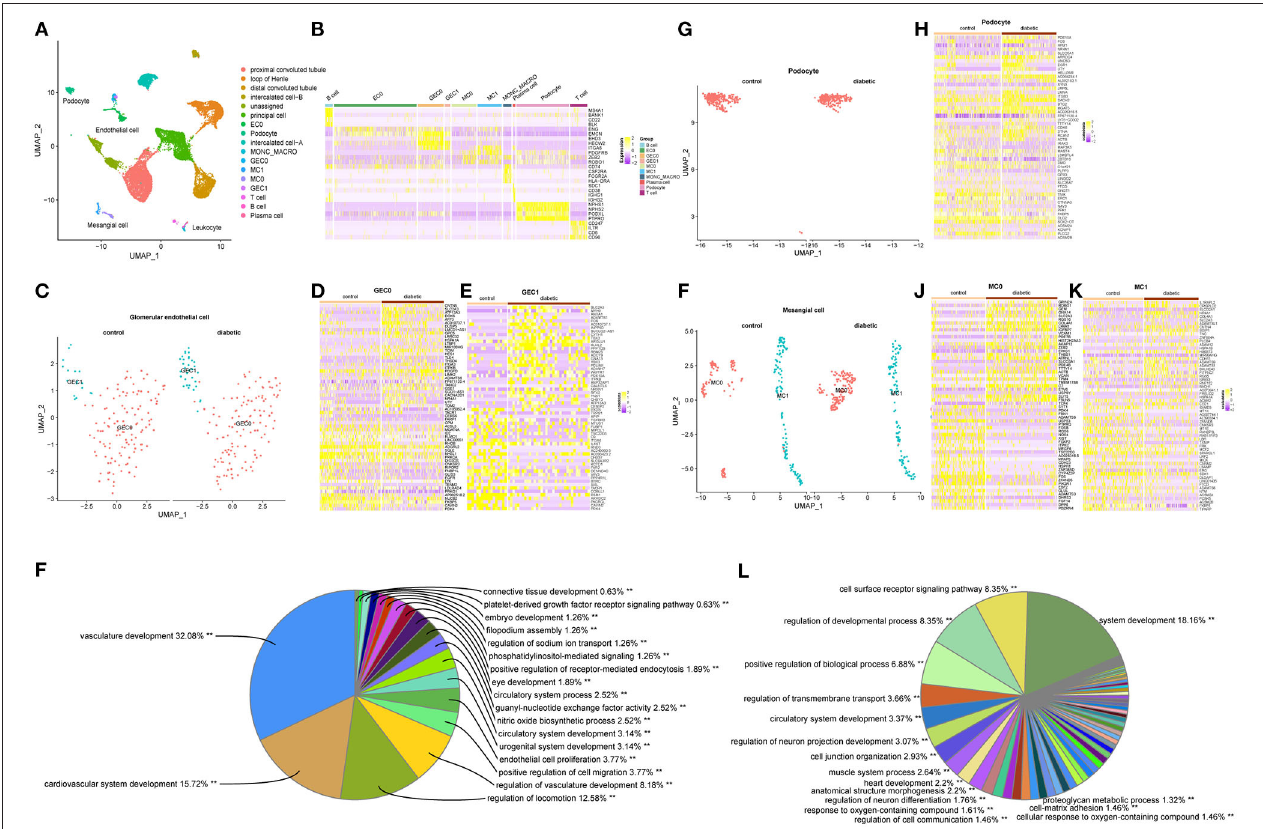
FIGURE 1 | (A) UMAP plot from unsupervised clustering of 23,980 cells from kidney cortex of healthy subjects and patients with diabetic nephropathy. (B) Expression levels of representative genes from each cluster. (C) UMAP plot of the two subclusters of glomerular endothelial cells. (D) Heatmap of top 30 up- and down-regulated DEGs in GEC0. (E) Heatmap of top 30 up- and down-regulated DEGs of GEC1. (F) Pie chart of significantly enriched GO terms group of GEC1. (G) UMAP plot of podocytes in healthy and diabetic conditions. (H) Heatmap of DEGs of podocytes. (I) UMAP plot of the two subclusters of mesangial cells. (J) Heatmap of top 30 up- and down-regulated DEGs in MC0. (K) Heatmap of top 30 up- and down-regulated DEGs in MC1. (L) Pie chart of significantly enriched GO terms group from DEGs of MC1. P -value < 0.05 were considered statistically different.